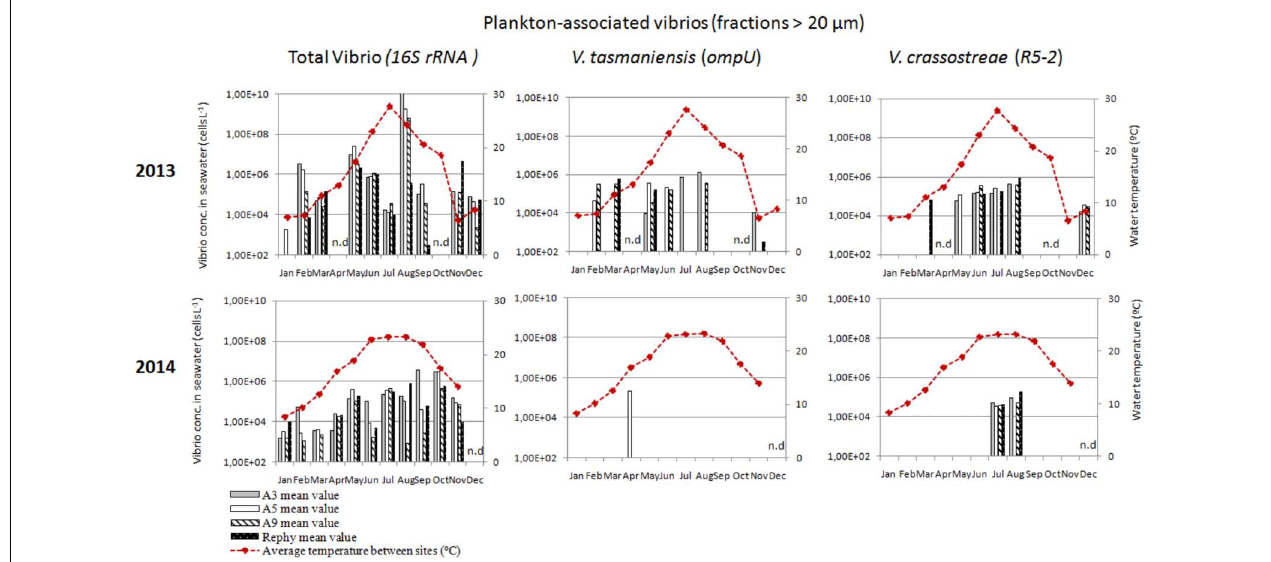
FIGURE 3 | Monthly abundance of plankton-associated vibrios in the water column. Histograms show apparent vibrio concentrations based on qPCR amplification ( 16S rRNA , ompU , and R5-2 ) of DNA extracted from the > 20 µ m fraction of the water column. Samples were collected outside the oyster culture area (A3, gray bars and A5, white bars ) and inside an oyster farm (A9, hatched white bars and Rephy, hatched black bars ). Mean seawater temperature ( ◦ C) is represented by a red line. n.d., not determined.